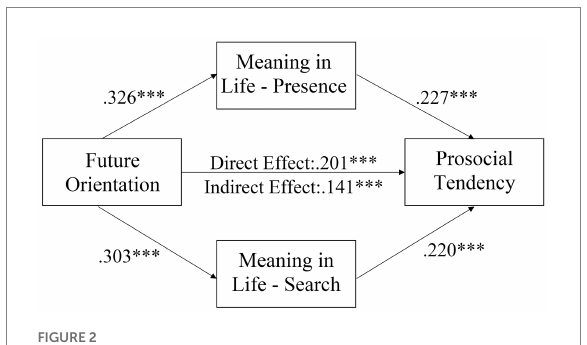
FIGURE 2 A hypothetical model for the relationships among major variables. * p < 0.05; ** p < 0.01, *** p < 0.001.